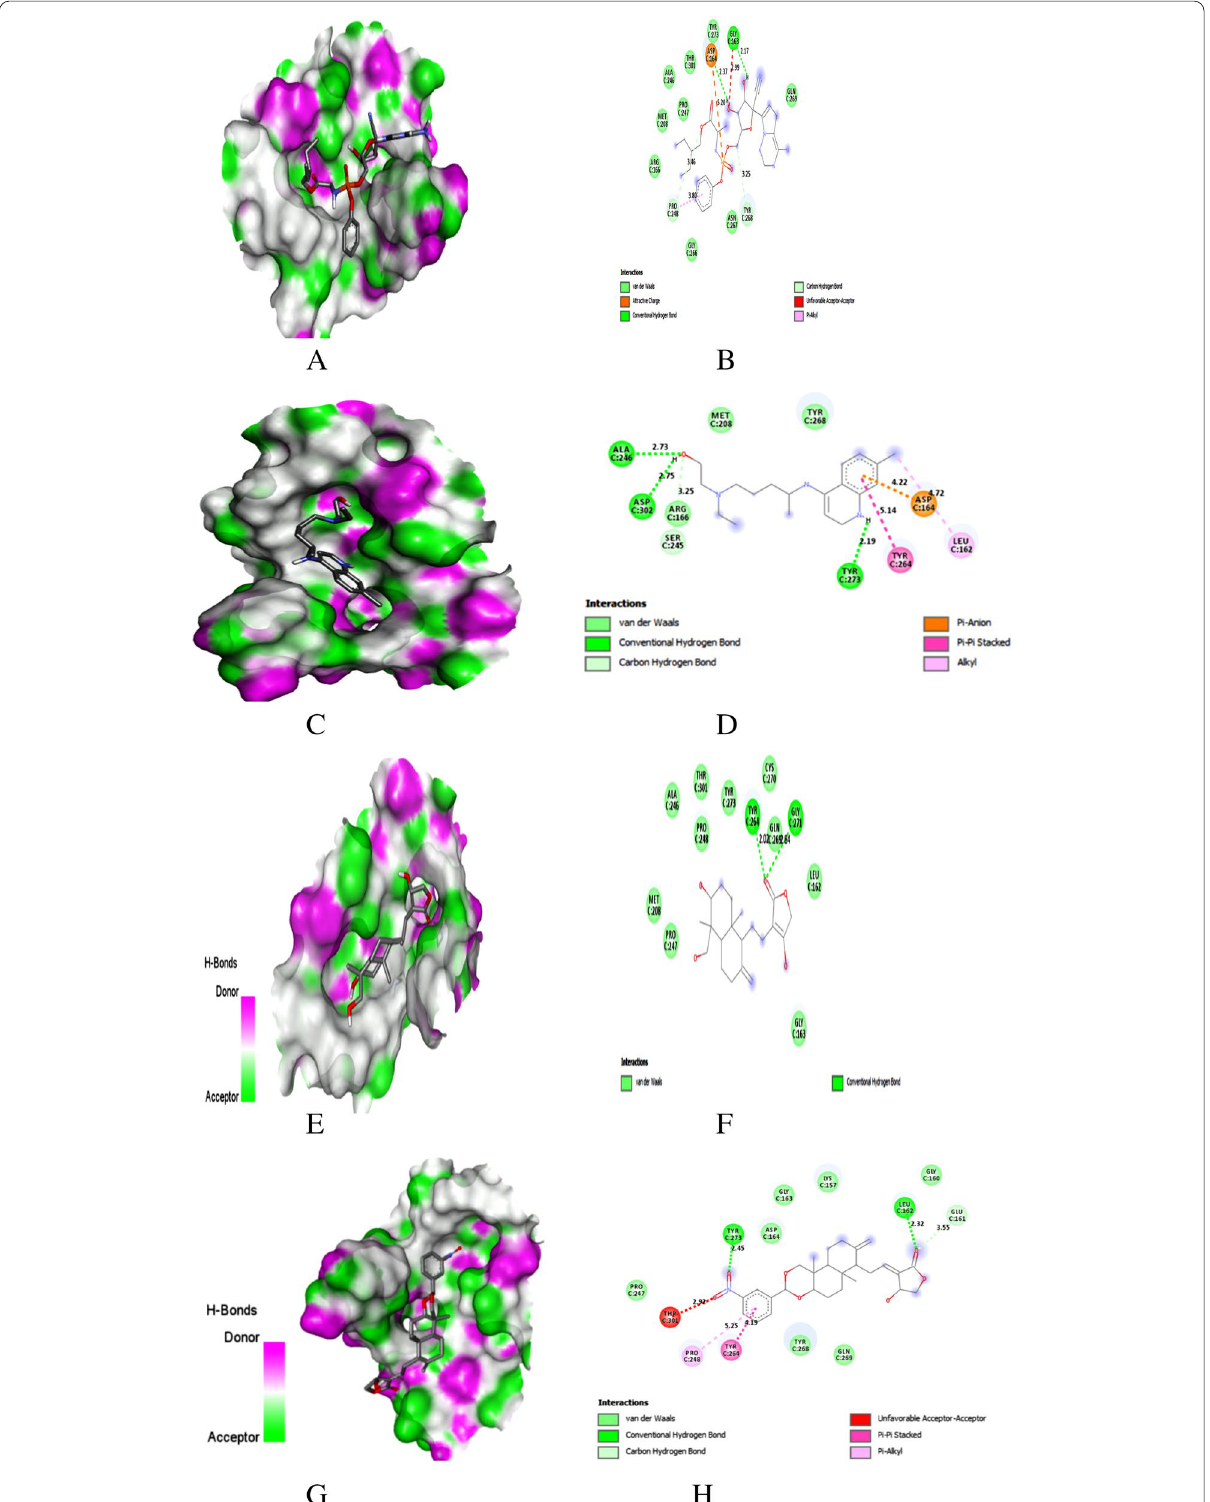
Fig. 4 Docking with PLpro. A Docking pose of REM on hydrogen bonding surface. B ) 2D interaction of REM. C Docking pose of HCQ on hydrogen bonding surface. D 2D interaction of HCQ. E Docking pose of AGP on hydrogen bonding surface F 2D interaction of AGP. G Docking pose of AGP-14 on hydrogen bonding surface. H 2D interaction of